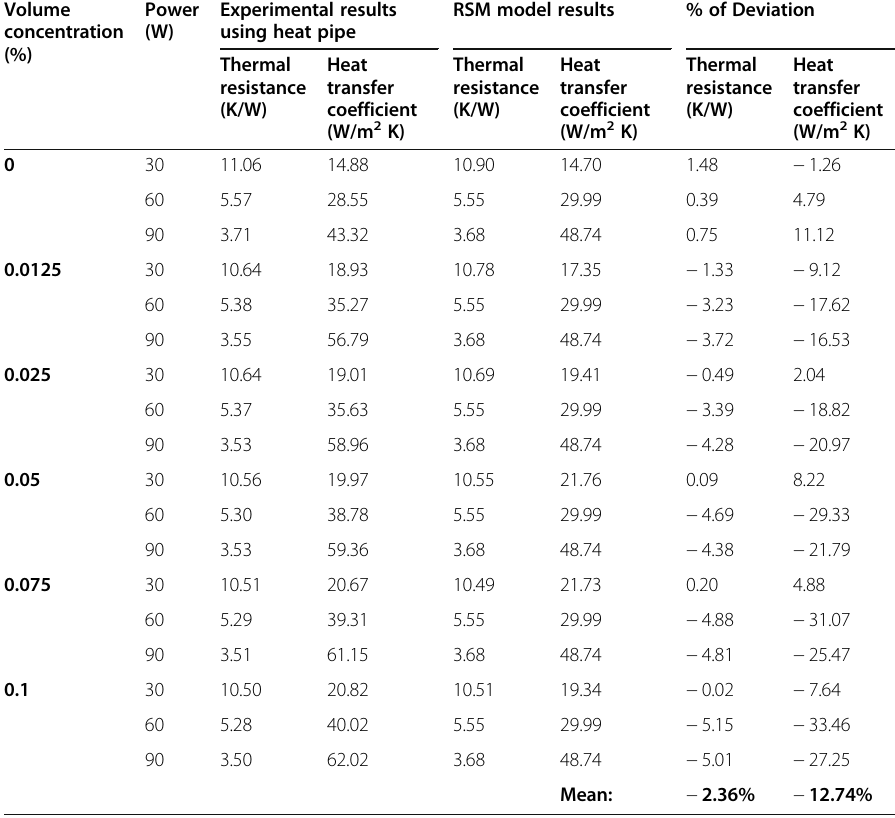
Table 4 Comparison between experimental and RSM model results Volume Power Experimental results concentration (W) using heat (%)